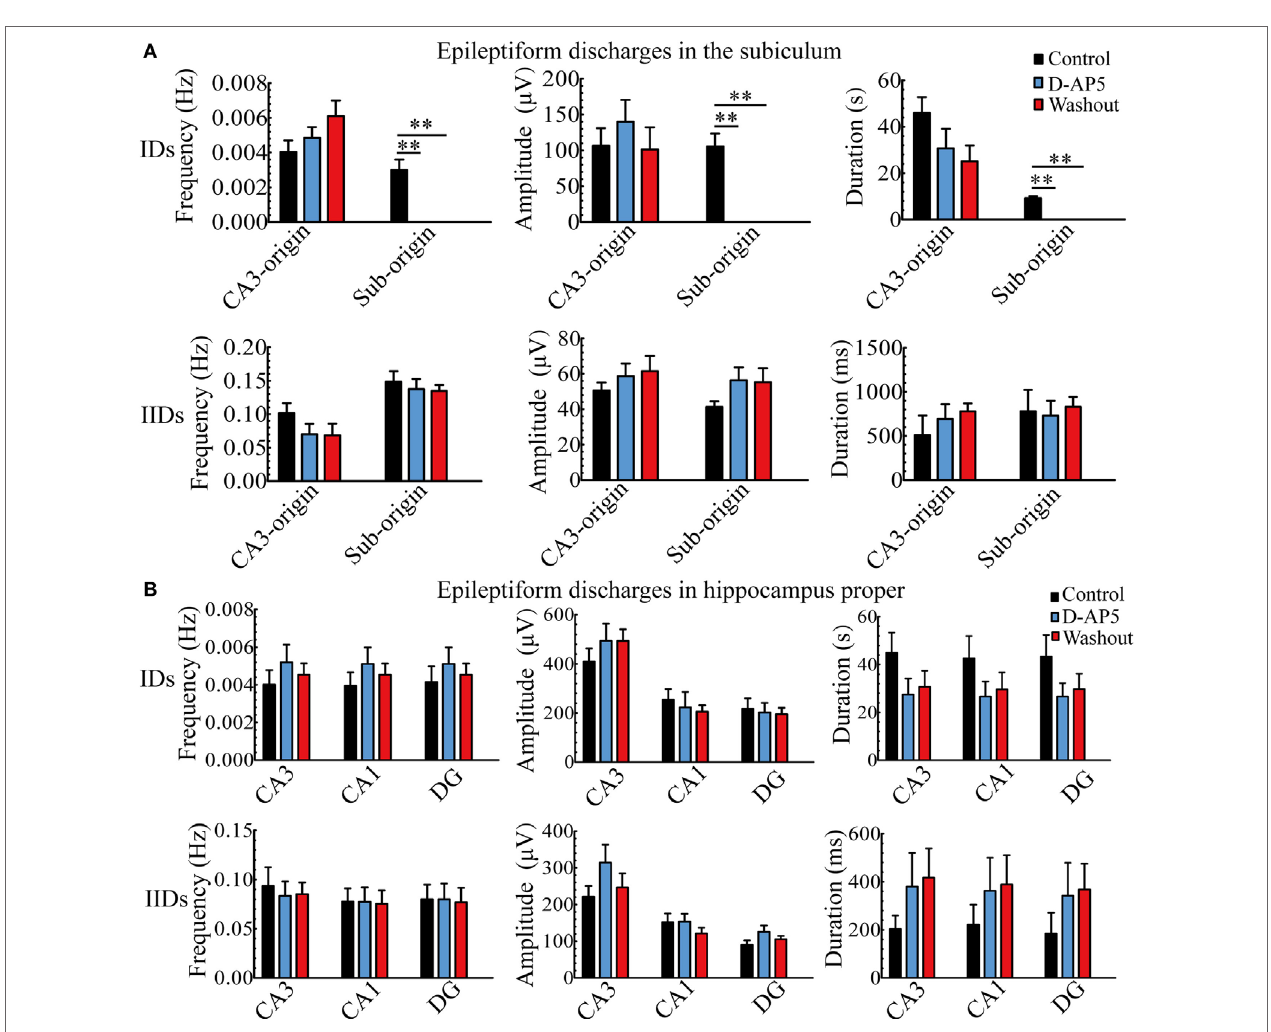
FigUre 9 | The effect of d -aP5 upon the parameters of epileptiform discharges . (a) The effect of d -AP5 upon the CA3- and Sub-origin epileptiform discharges in the subiculum. During d -AP5 application, the Sub-origin ictal-like discharges (IDs) were abolished; the frequencies, amplitudes, and durations of Sub-origin interictal-like discharge (IIDs) and CA3-origin IDs/IIDs were not significantly different with the Control/Washout group [ P > 0.05, one-way analysis of variance (ANOVA), n = 5]. (B) The effect of d -AP5 upon the epileptiform discharges in the hippocampus proper (HP). The effect of d -AP5 upon the IDs/IIDs in the HP was similar to that upon the CA3-origin IDs/IIDs in the subiculum.